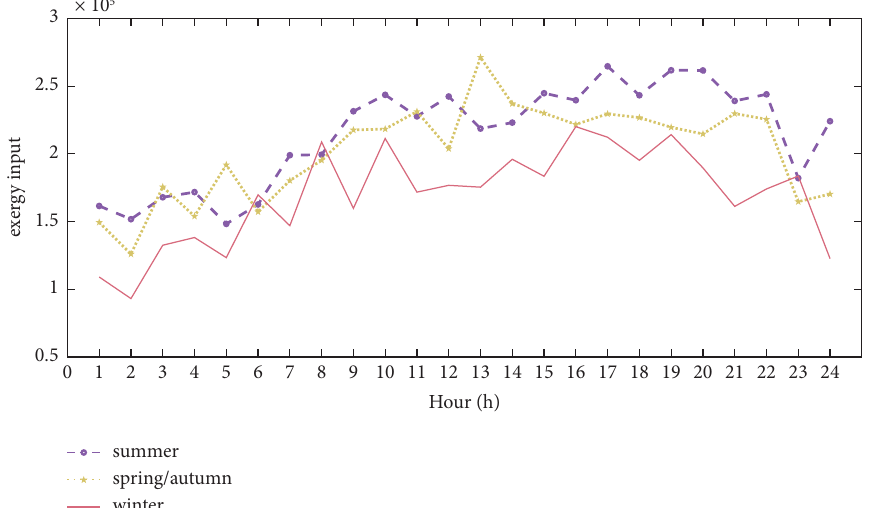
Figure 17: Exergy input of typical day in diferent seasons.